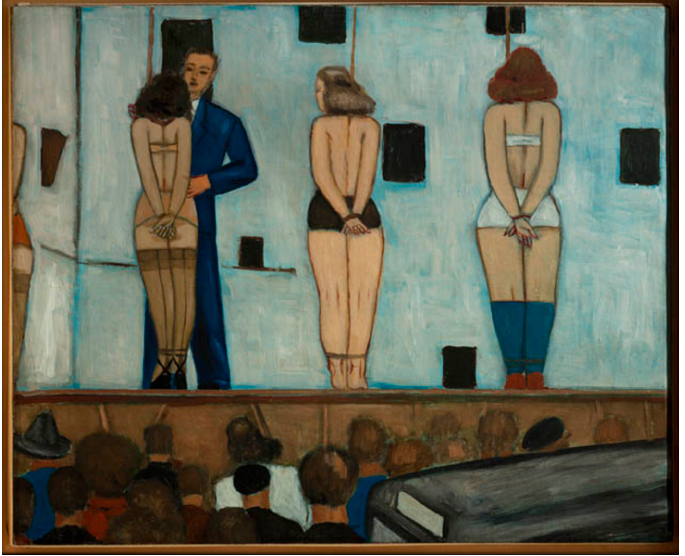
Figure 2. Jerzy Nowosielski, Execution, 1949, oil on canvas. National Museum in Krakow. Photography by M. Gardulski/Galeria Starmach. Reproduced with permission.